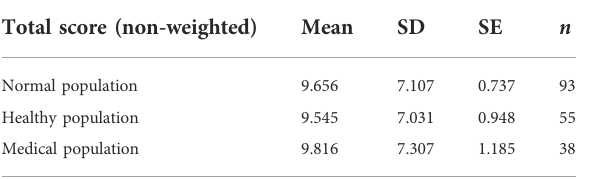
TABLE 4 SSQ total scores.